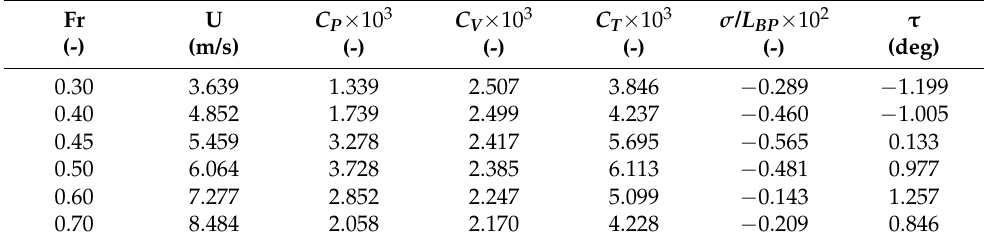
Table 8. Calm water resistance and motion results of the full-scale Double-M craft.